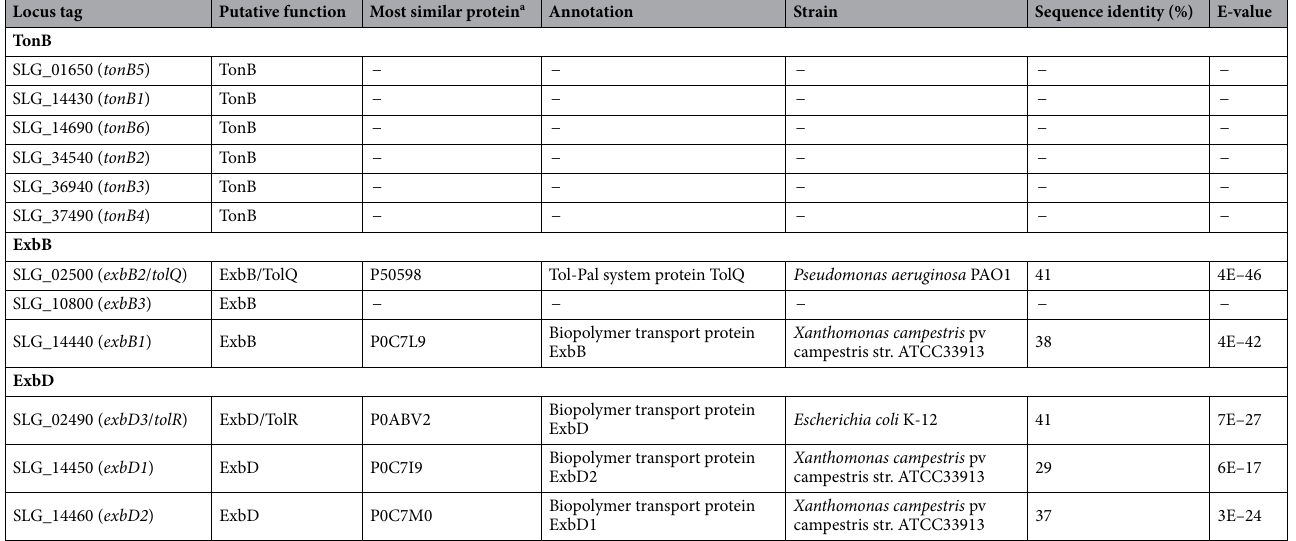
Table 1. Candidate genes encoding the Ton complex components in Sphingobium sp. strain SYK-6. a Most similar proteins were searched in the Swiss-Prot database using the BLAST-P program 40 and not displayed if the E-value is greater than